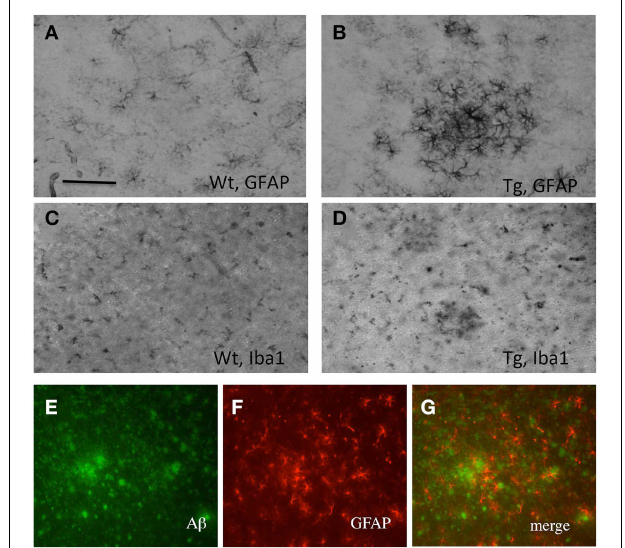
FIGURE 2 | Characterization of plaques in vibrosections of 9 month old amyloid-precursor protein_SDI transgenic mouse model. Organotypic vibrosections of 9 month old wildtype (Wt; A,C ) or transgenic (Tg; B,D–G ) mice were prepared (120 µ m thick) and cultured for 2 weeks, then fixed and immunohistochemically stained for astroglial glial-fibrillary acidic protein (GFAP; A,B,F ) or microglial Iba1 (C,D) . Astroglial GFAP (F) was co-stained with beta-amyloid (E) , showing reactive astroglia around plaques (G) . Scale bar in A = 150 µ m (A–D) and 100 µ m (E–G)